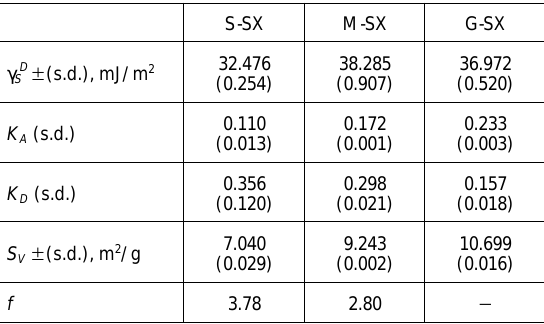
Table III The dispersive component of the surface free energy, γ SD , the acidic, K A , and basic, K D , surface parameters, surface area, S V and calculated particle shape factor, f .